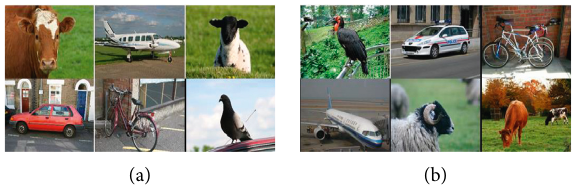
Figure 4: Image samples from (a) MSRC and (b) VOC2007.